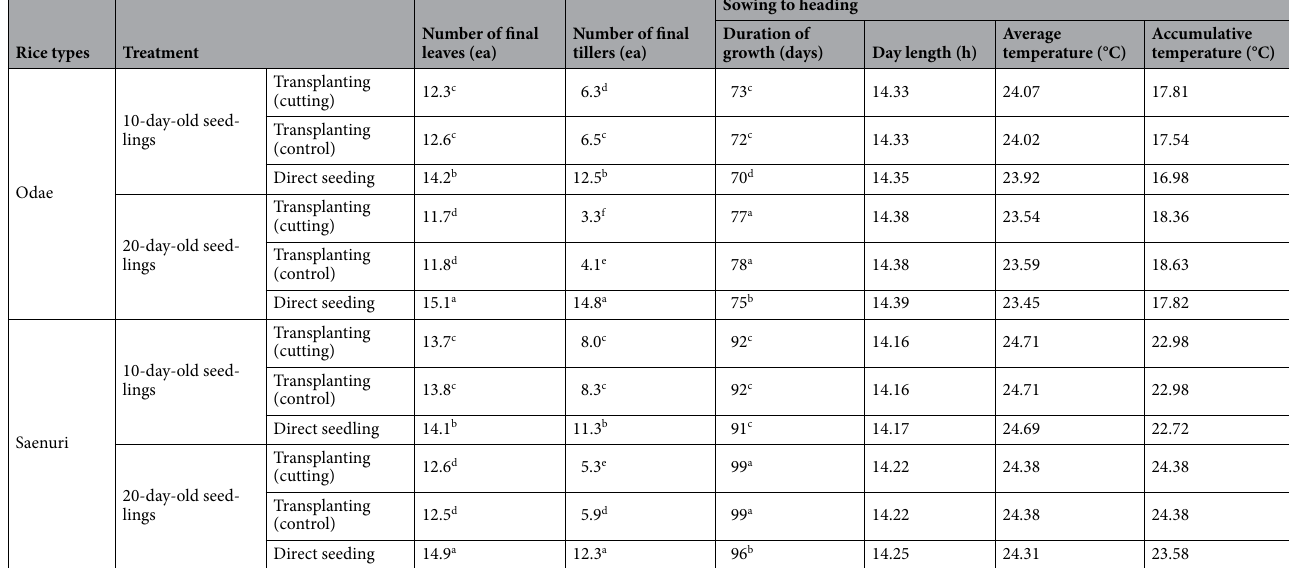
Table 3. The final number of rice leaves and tillers and environmental conditions during the growing period in relation to the number of seeding days and root cutting conditions. Significant differences were evaluated using Duncan’s multiple range test at the 5% level. Within each column, values followed by different letters (a to f) are significantly different (P <